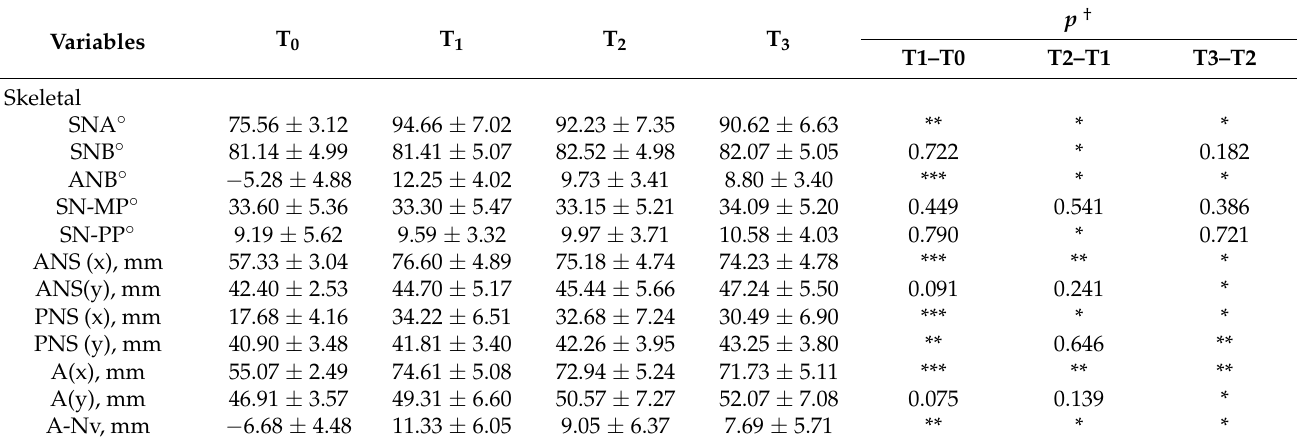
Table 5. The mean changes of the skeletal, dental, and soft tissue components based on serial cephalograms in the bone-borne RED